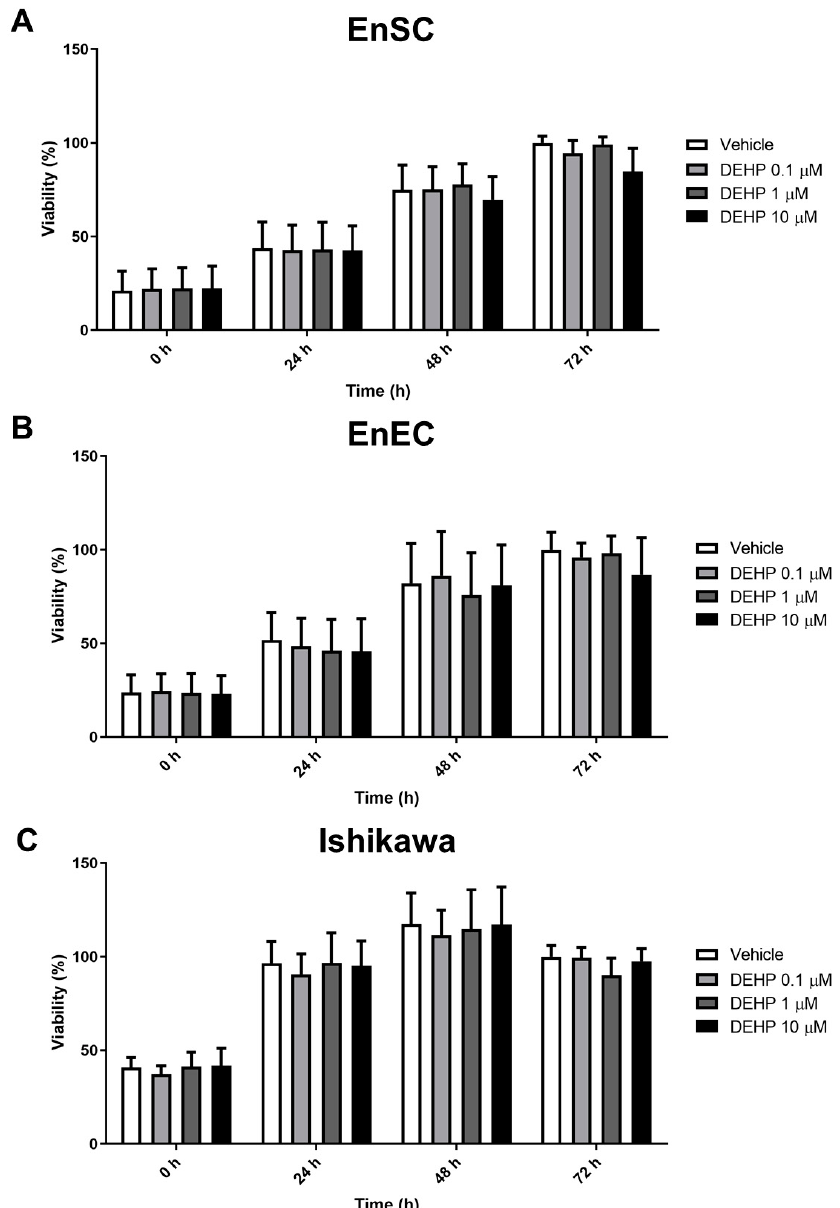
Figure 1. Endometrial cell viability following acute DEHP exposure. Primary EnSC ( A ), primary EnEC ( B ), and Ishikawa cells ( C ) were exposed to DEHP at 0.1, 1, and 10 µ M. After treatment, viability was assessed with the MTS assay every 24 h. The results expressed in OD are relative to the vehicle at 72 h, represented as percentage ± SD of six different samples in the case of primary cells and three independent experiments in the case of Ishikawa cells. Each sample/experiment was performed in triplicate.